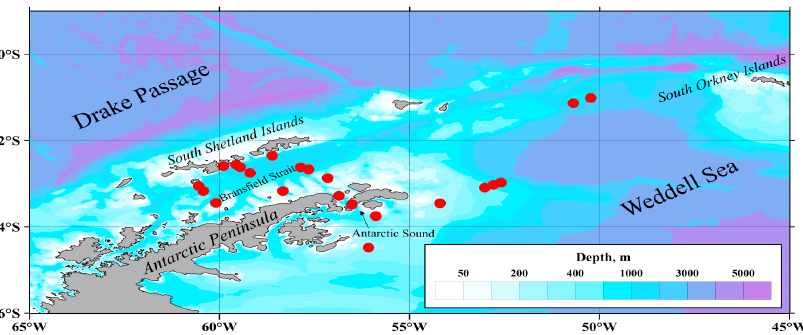
Figure 1. Location of water sampling sites for trace elements analysis in 87th cruise of R/V “Akademik Mstislav Keldysh”.